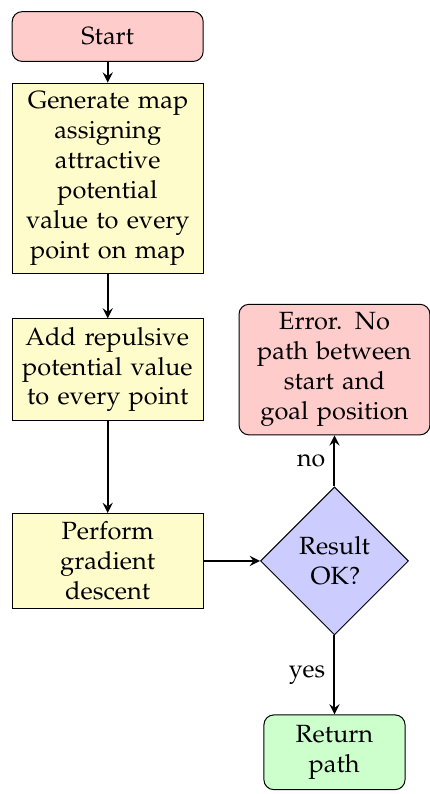
Figure 4. Potential Fields sequence